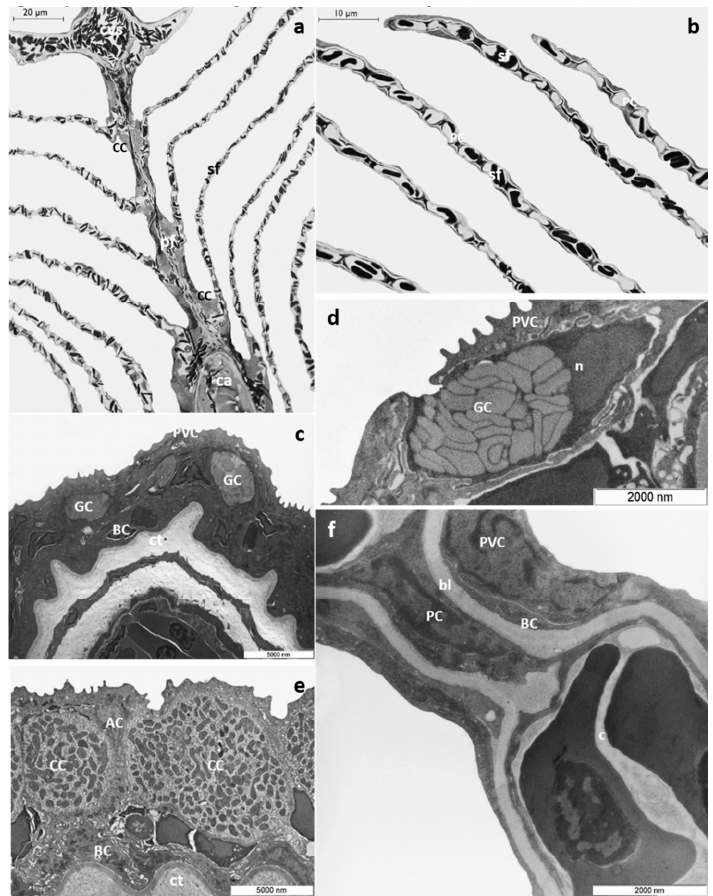
Figure 1. T. pavo gills under basal conditions. ( a ) Light micrograph of a primary gill filament (pf) and secondary lamellae (sf). Note the chloride cells (CC) distributed along the filament margins and in the interlamellar region; ca=cartilage, cvs=central venous sinus. ( b ) Light micrograph of secondary lamellae (sf); PC= pillar cell. ( c ) Ultrastructural organization of the primary epithelium; PVC= pavement cell, GC= goblet cell, bc= basal cell; ct= connective tissue. Note the PVCs in the outermost layer. ( d ) High magnification micrograph of a goblet cell (GC) showing large clear electron granules; PVC= pavement cell, n= nucleus. ( e ) High magnification micrograph of a chloride cell (CC); note the numerous mitochondria and the typical tubular vesicular system; AC= accessory cell, BC= basal cell, ct= connective tissue. ( f ) TEM micrograph showing a secondary lamella; PVC= pavement cell, BC= basal cell, PC= pillar cell, bl= basal lamina.